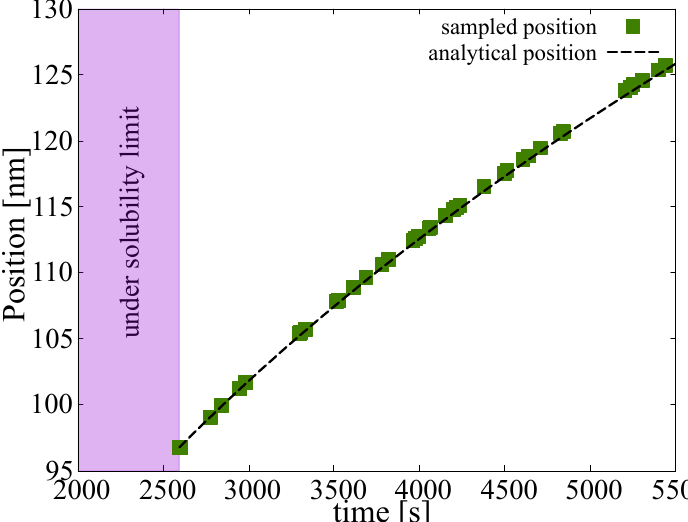
Figure 6. Comparison between the predictions of r i and Equation (18) of the position of the oxide/metal interface as a function of time. We track the interface position only after the concentration of hydrogen has reached the solubility